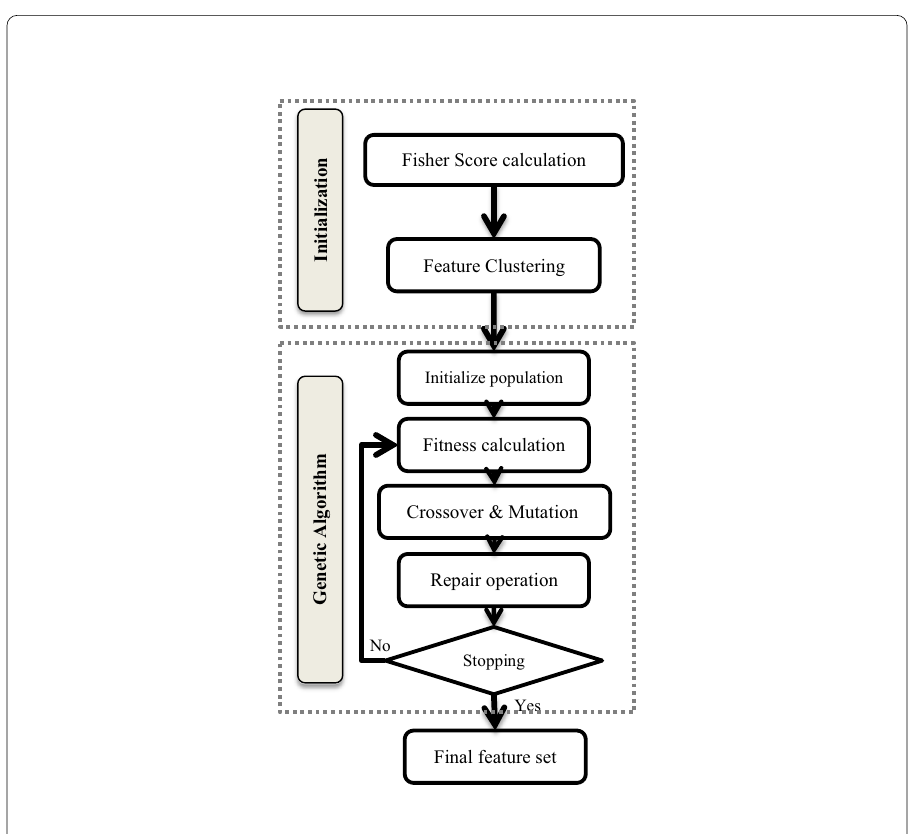
Fig. 1 Flowchart of the proposed